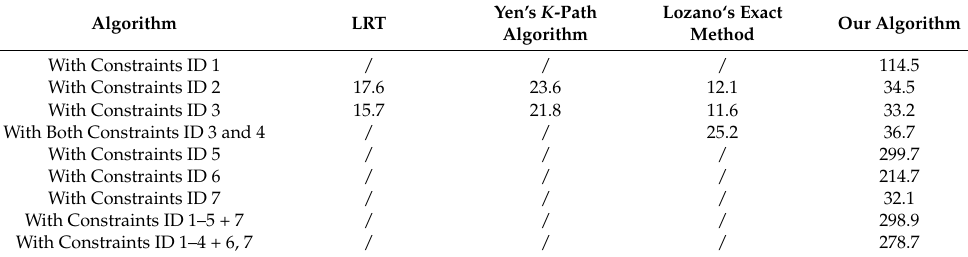
Table 4. Average time costs of different algorithms with different constraints (unit: second/s)